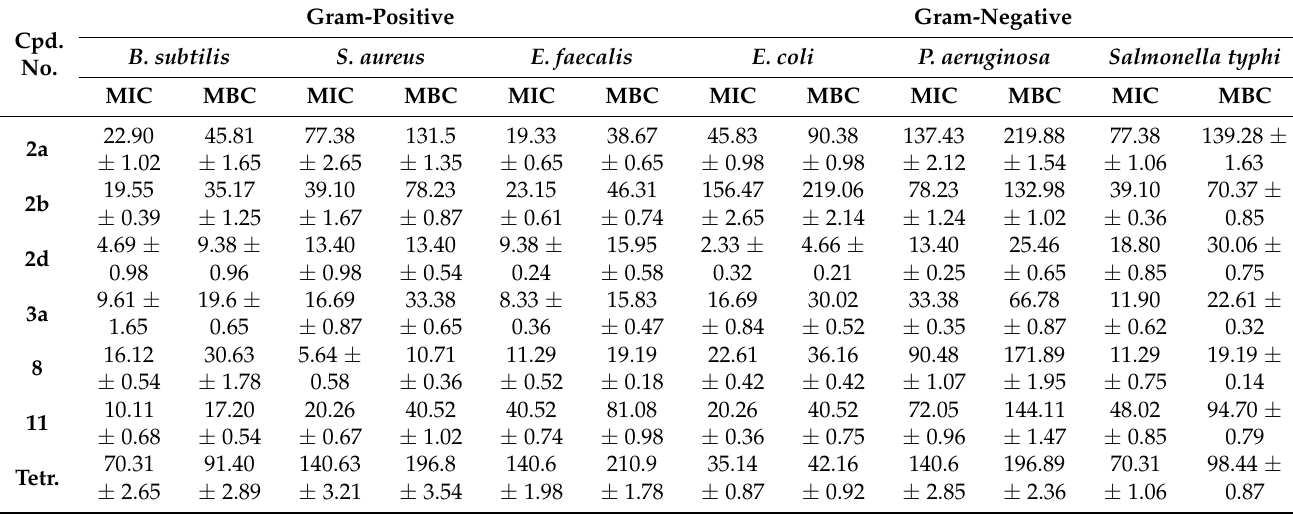
Table 2. In vitro antibacterial activity (minimal inhibitory/bactericidal concentrations, MIC and MBC), expressed in µ M, for the potency derivatives.